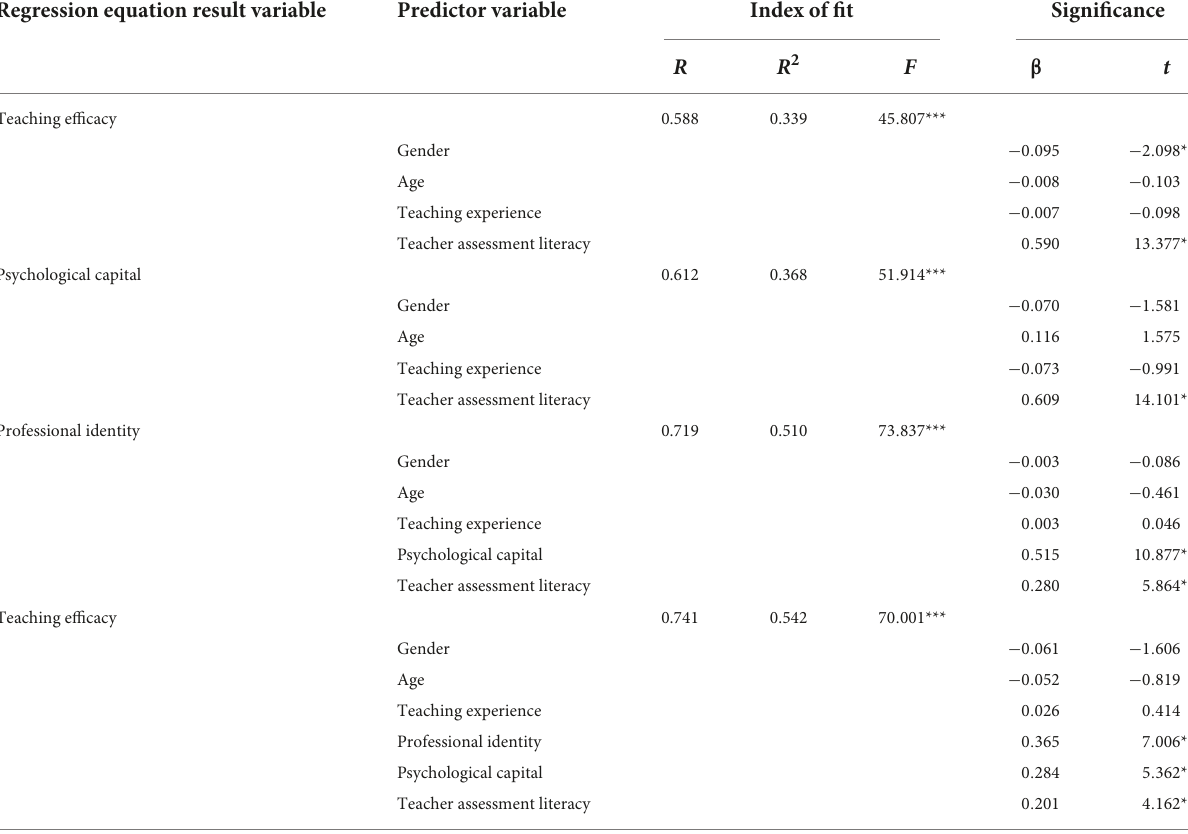
TABLE 2 Regression analysis of the relationship between teacher assessment literacy and teaching efficacy.